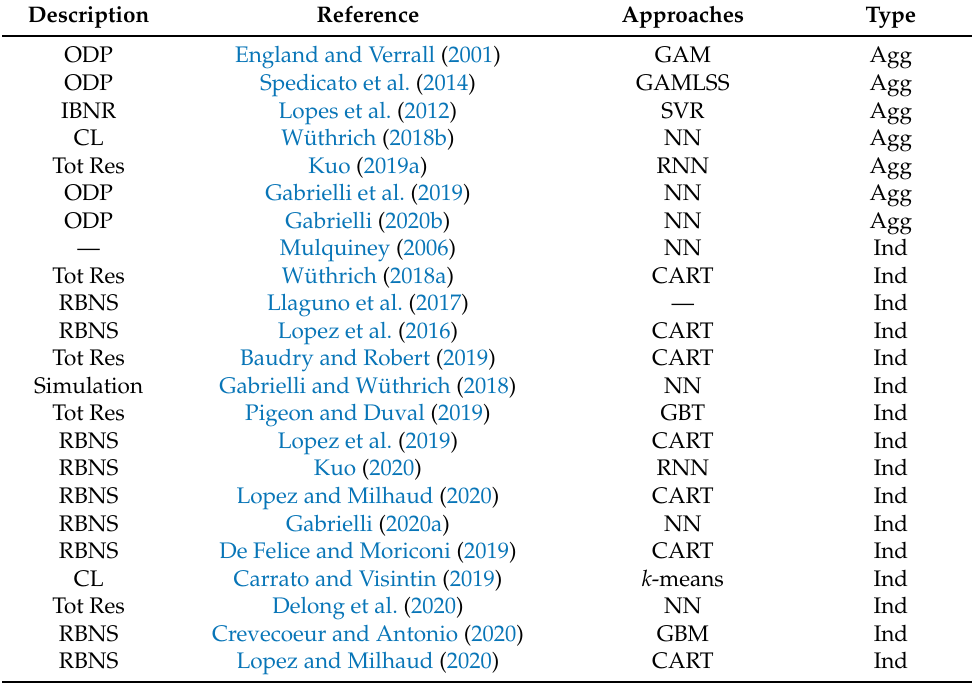
Table 4. Summary of contributions in